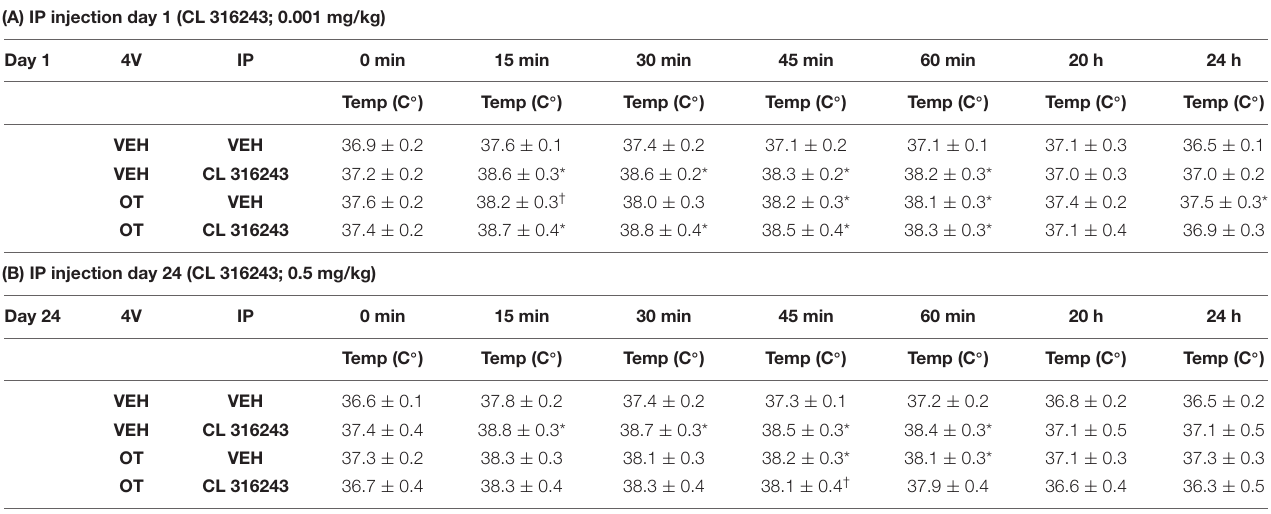
TABLE 2 | T IBAT measurements following acute systemic administration of the beta-3 receptor agonist (CL 316243) or vehicle in male DIO rats. (A) IP injection day 1 (CL 316243; 0.001